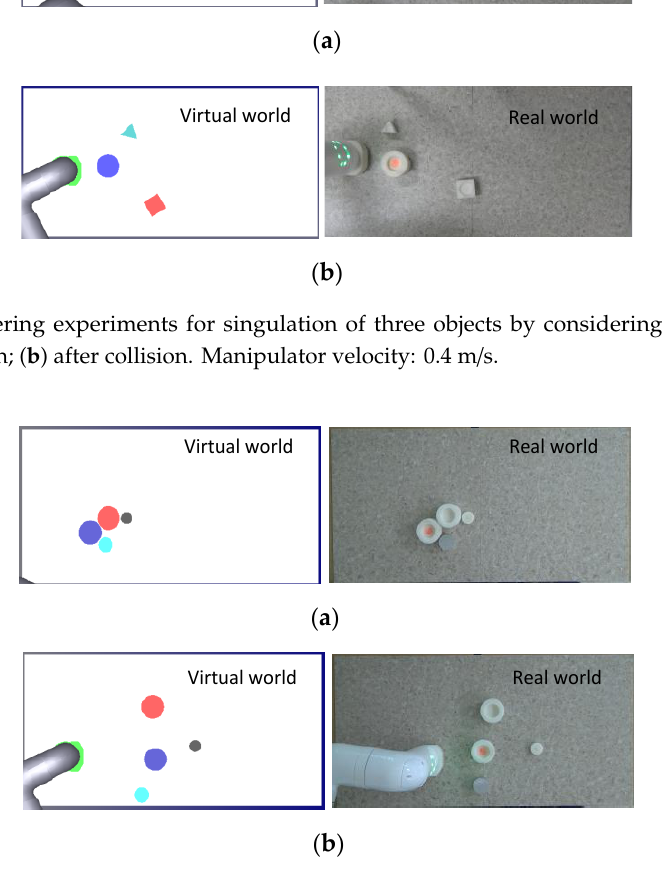
Figure 15. Scattering experiments for singulation of four objects by considering circular shapes only: ( a ) before collision; ( b ) after collision. Manipulator velocity: 0.6 m/s.